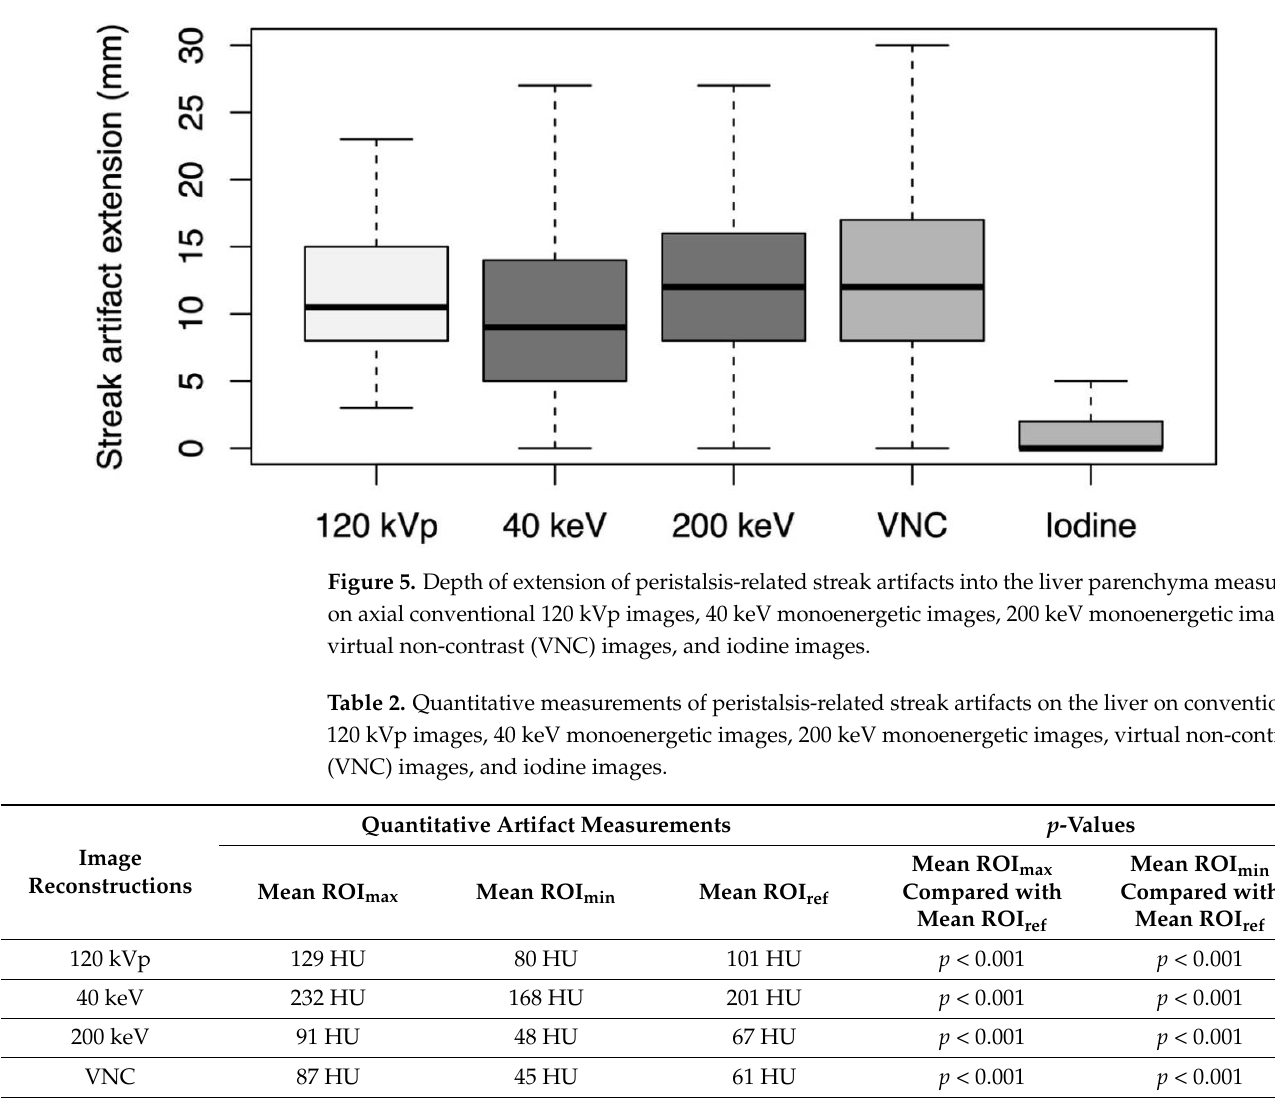
Table 2. Quantitative measurements of peristalsis-related streak artifacts on the liver on conven- tional 120 kVp images, 40 keV monoenergetic images, 200 keV monoenergetic images, virtual non- contrast (VNC) images, and iodine images.